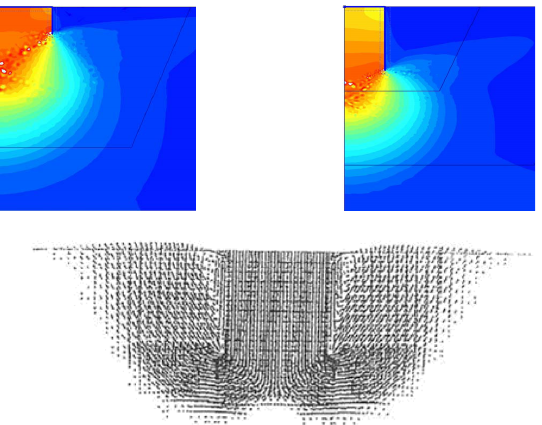
Fig. 17. Ultimate vertical bearing capacity as a function of embedment ratio for Yoldia clay Fig. 18. Comparison of kinematic mechanisms accompanying failure of bucket foundations in homogeneous soil and skirted foundations in normally consolidated soils: a) bucket with em- bedment ratio 0.25; b) bucket with embedment ratio 1; c)